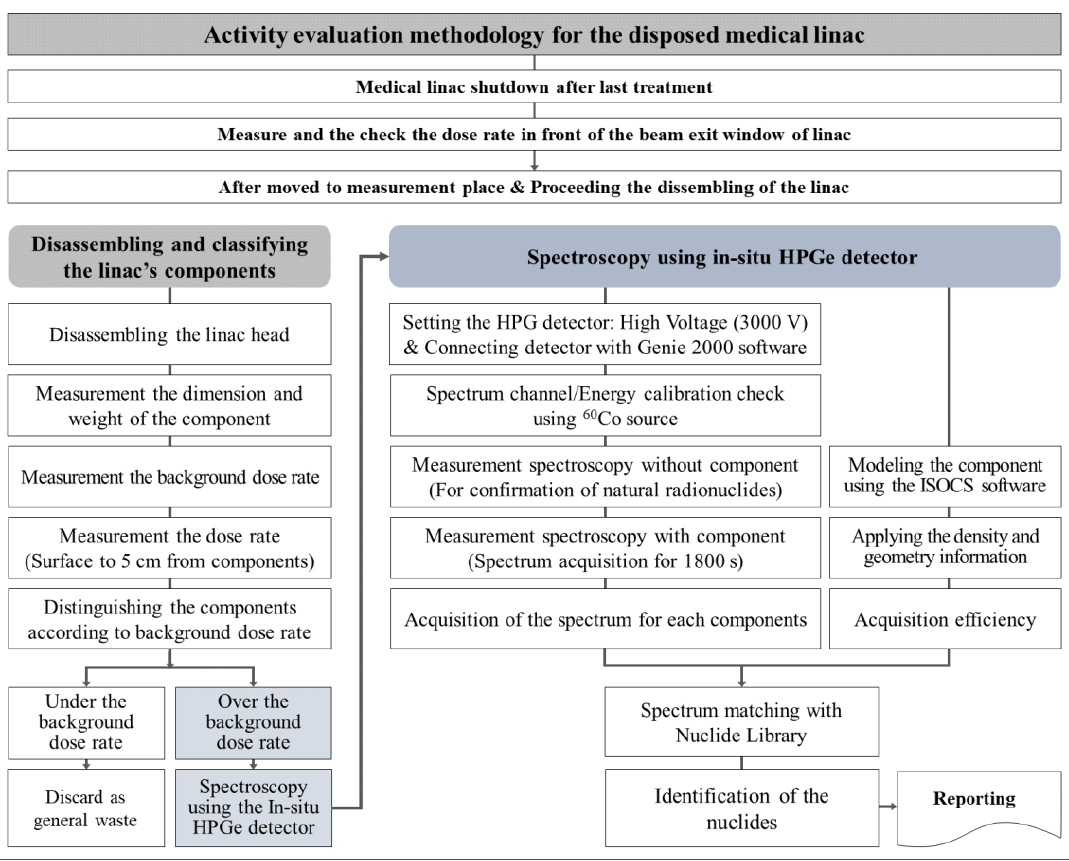
Figure 2. Procedure of the activity evaluation methodology for the disposed medical linac.